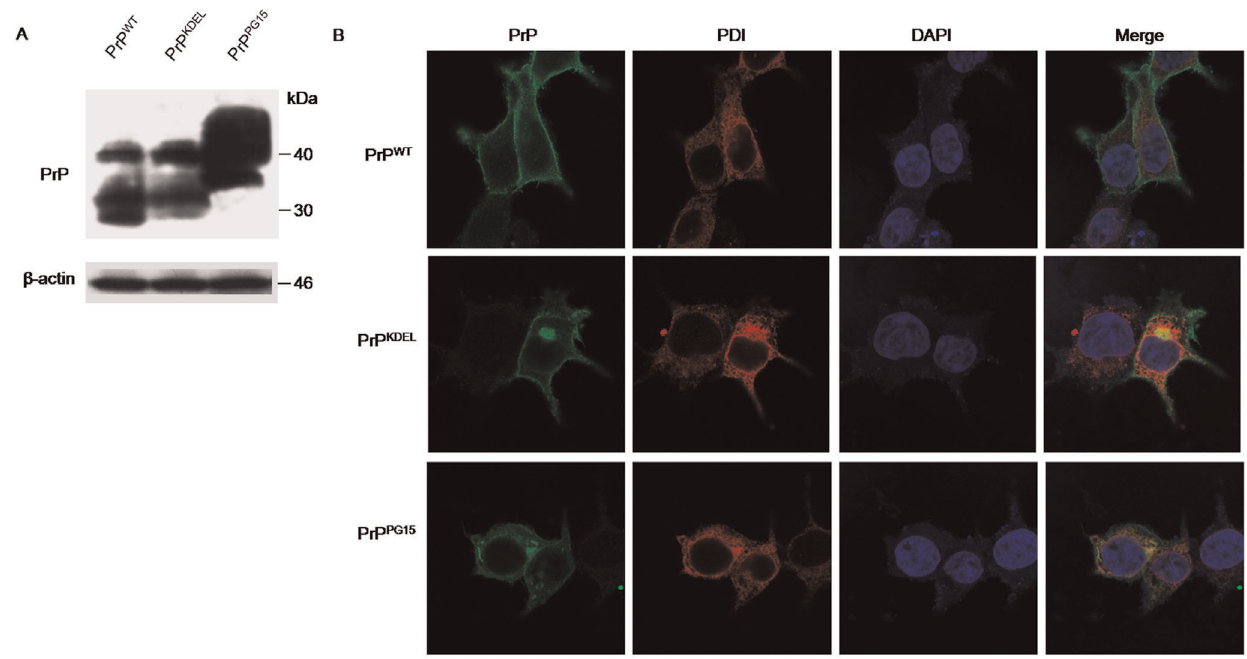
Figure 2. Expressions of transiently transfected PrP constructs and co-localizations of the expressed PrPs with PDI in 293-T cells. A. Western blots of the expressions of wild-type PrP (PrP WT ) and PrP mutants (PrP KDEL and PrP PG15 ). B. Immunocytochemial assays of the cells transfected with various PrP constructs 48 h after transfection. The images of PrP (green), PDI (red), DAPI (blue) and merge are monitored under a confocal microscopy and indicated above. ( 6 1000).